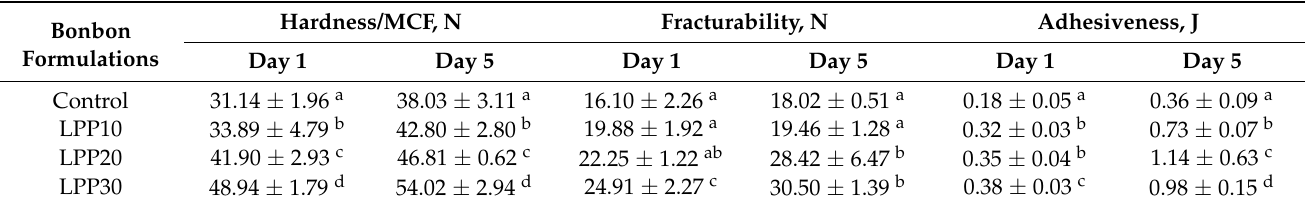
Table 6. Texture profile analysis of bonbon formulations.